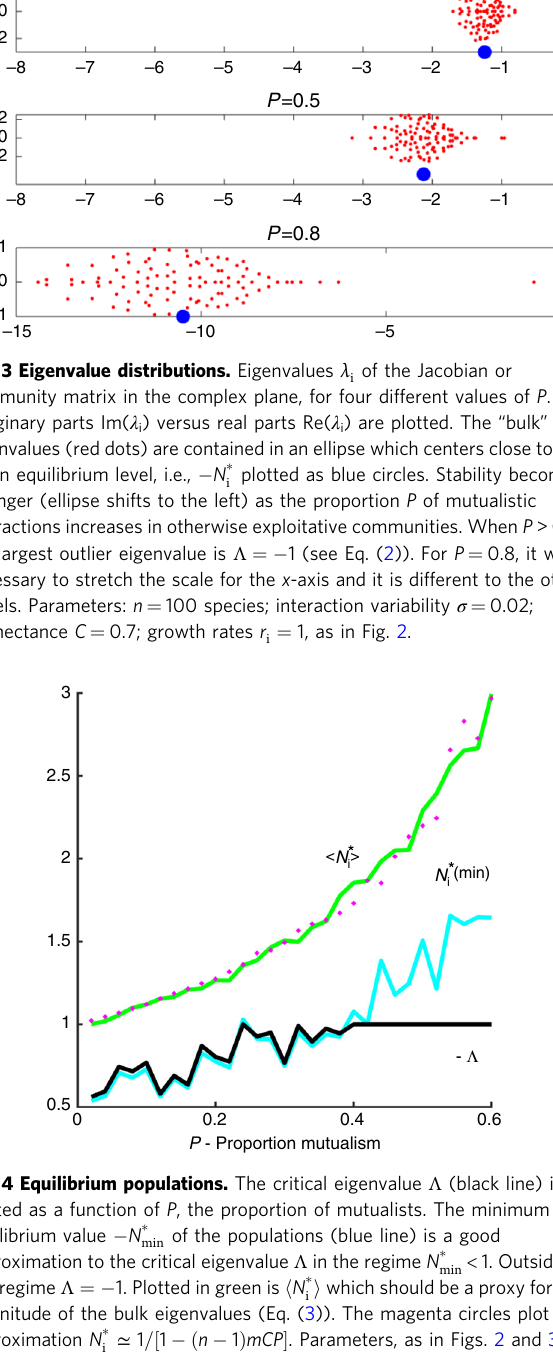
the left. The center of the ellipse can be well approximated by the mean equilibrium population level (cid:2) N * circle, indicating how the equilibrium populations increase in tandem with the eigenvalue distribution (see “ Methods ” section, Eq. (3)).